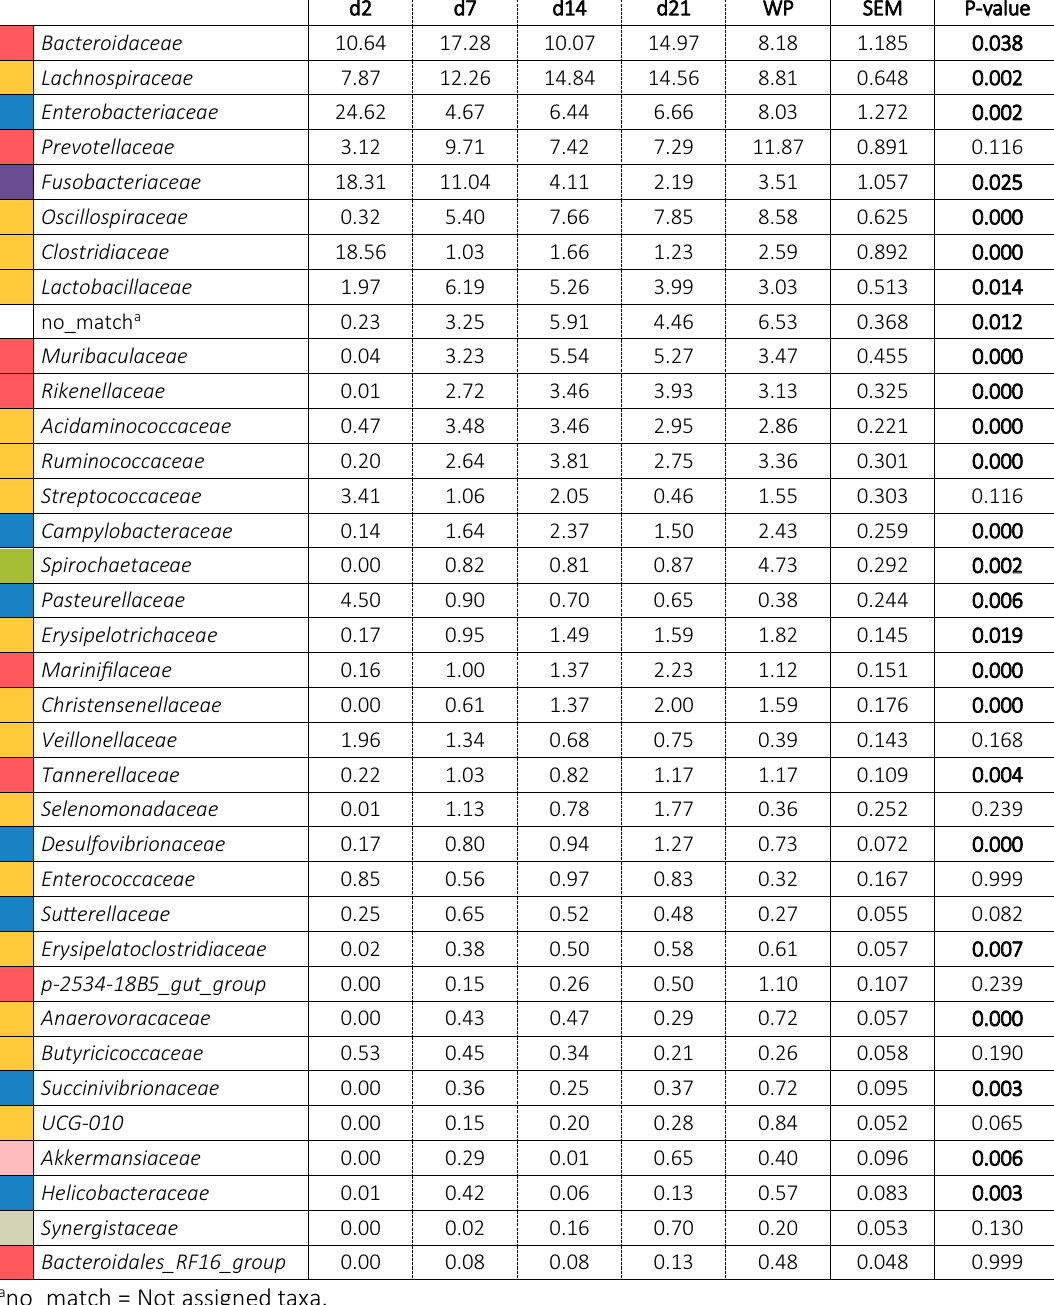
Table 2 Relative abundances (%) of the families present in the faecal microbiota of the piglets in a percentage higher than